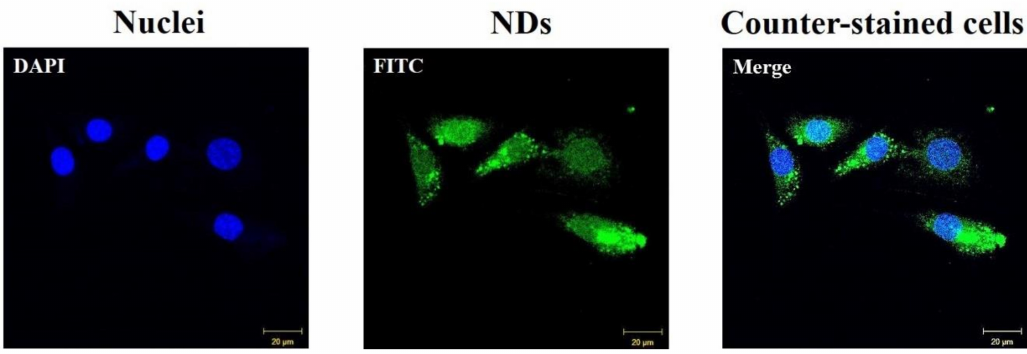
Figure 5. CLSM images of intracellular uptake of FITC-labeled NDs after 4 h of cultivation. Scale bar: 20 µ m.